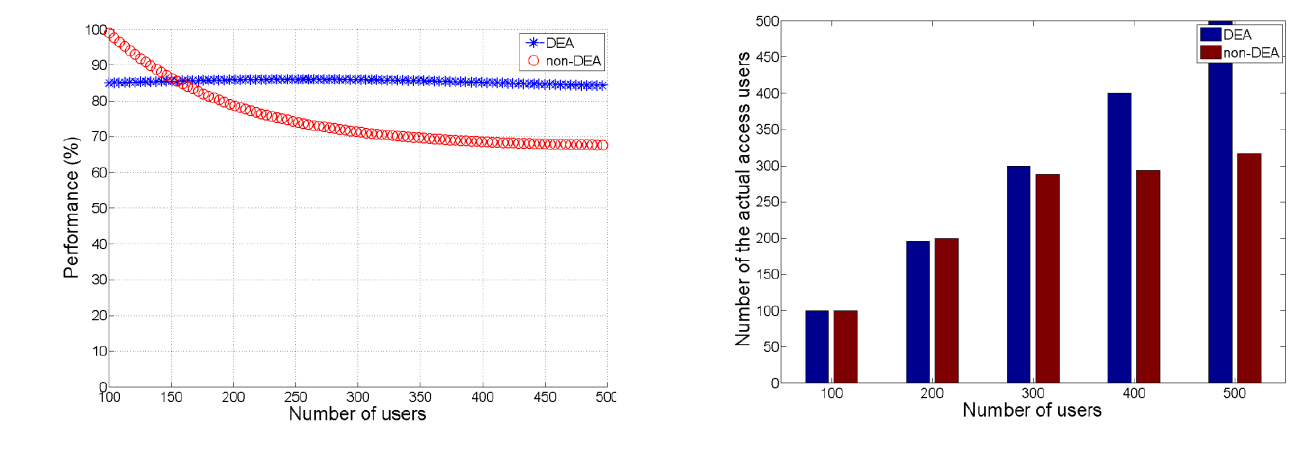
Figure 4. The number of users actually used the cloud system Figure 3. Performance Comparison